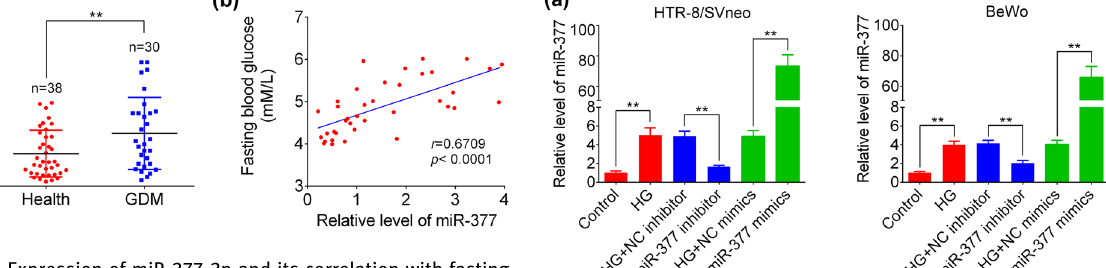
Figure 1: Expression of miR - 377 - 3p and its correlation with fasting blood glucose in GDM patients. ( a ) Serum expression of miR - 377 - 3p was upregulated in GDM patients compared with that in the healthy women. ( b ) Serum miR - 377 - 3p levels were positively correlated with the fasting blood glucose in GDM patients ( r = 0.6709, p < 0.0001 ) . The data are expressed as mean ± SEM; ** indicates p < 0.01.